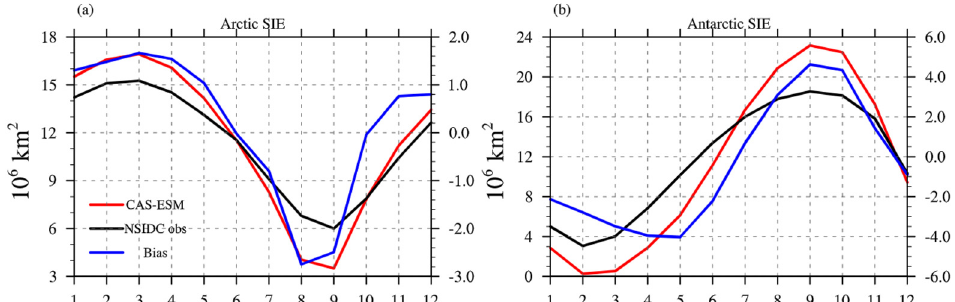
Figure 2. Seasonal cycles of ( a ) Arctic and ( b ) Antarctic SIE climatology (10 6 km 2 ) computed from simulated ensemble mean for 1979–2014 in historical simulation (red), satellite observations (black), and their biases (blue). The red and black curves correspond to the left axis, and the blue curve refers to the right axis. Observed data are from NSIDC [32]. SIE is areal sum of all grid points whose sea ice concentration exceeds 15%.